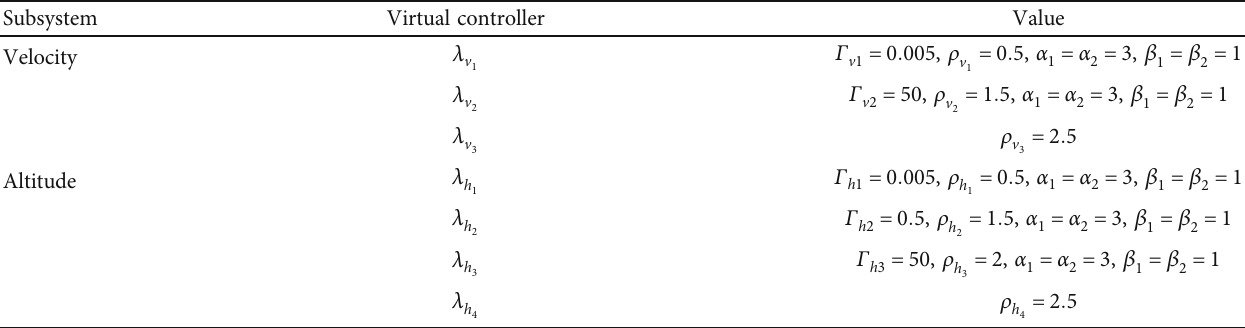
Table 3: The design parameters of DSC.